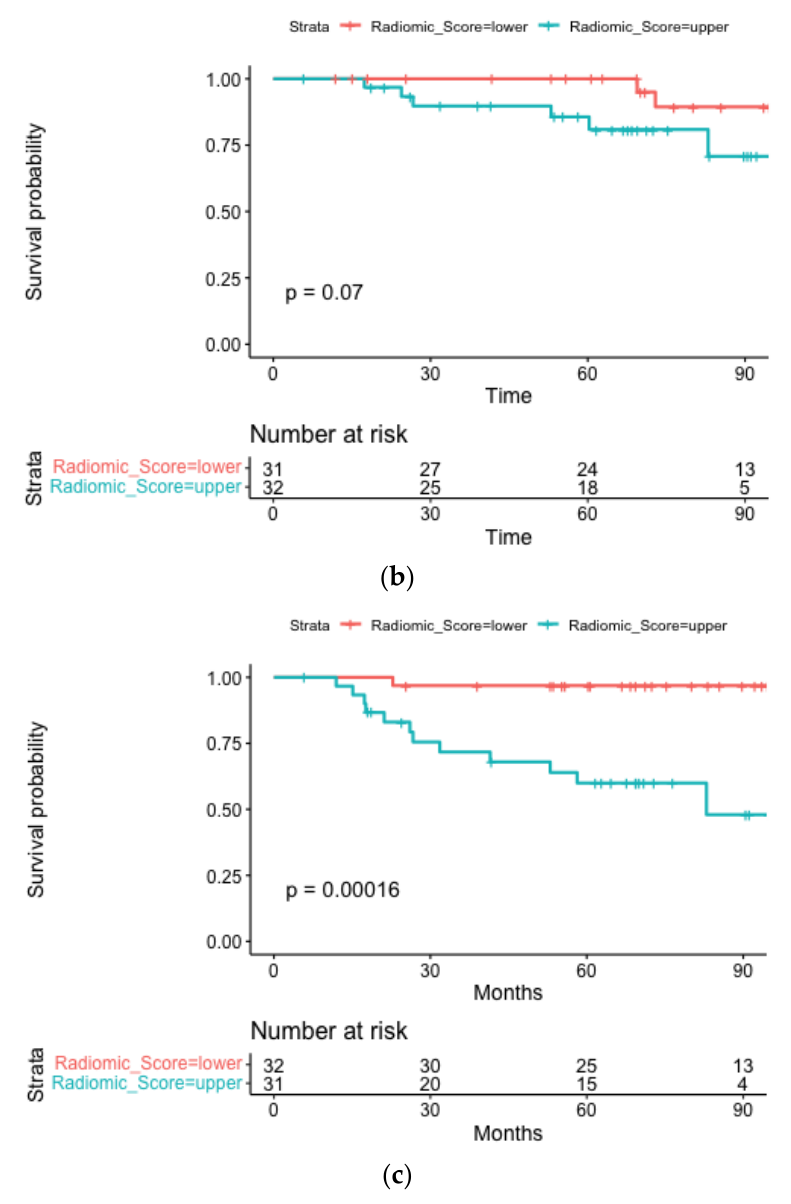
Figure 2. Kaplan-Meier curves stratified according to the radiomics score depicting OS ( a ), LRPFS ( b ), and DMFS ( c ) for the HPV positive